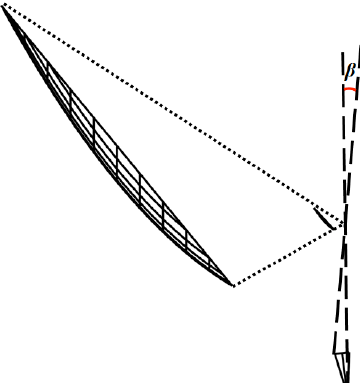
Figure 1: Optical arrangement of an offset Cassegrain antenna.